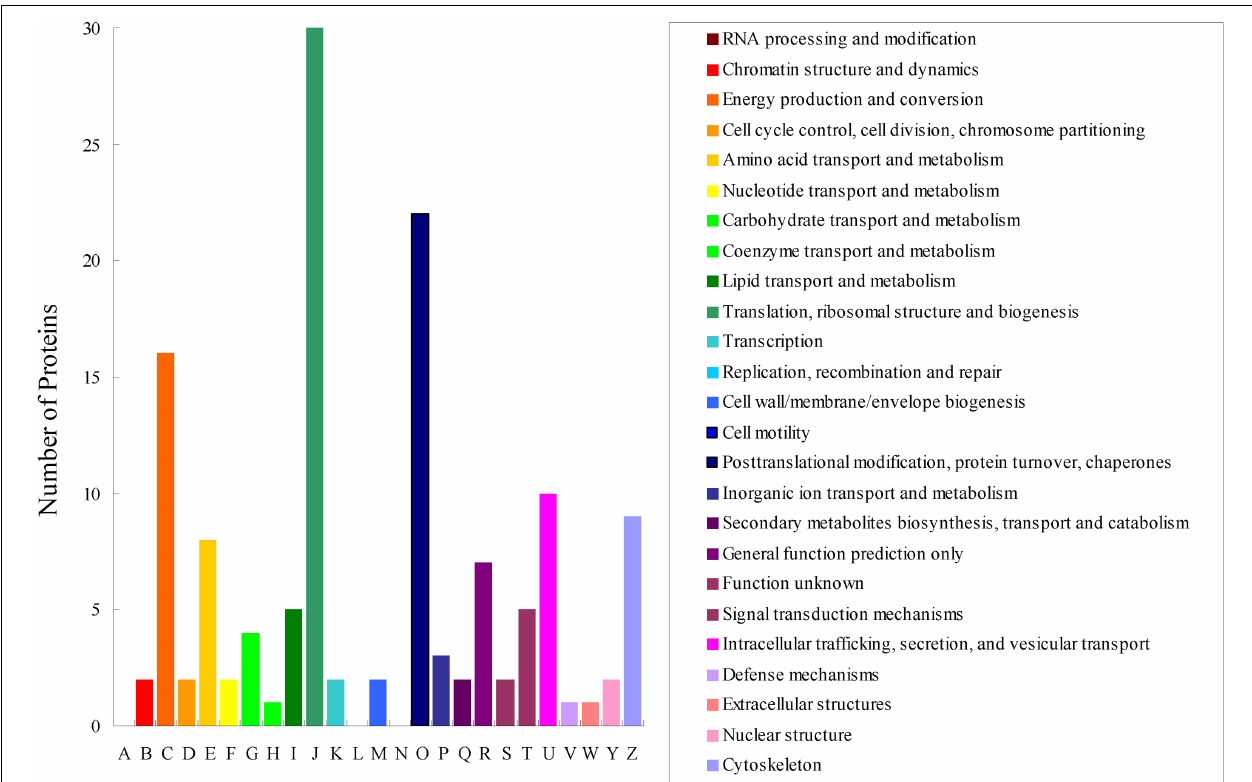
FIGURE 2 | COG functional classification of the differentially expressed proteins acquired via iTRAQ technology in the combinations CYR32-5 vs. CYR32, CYR32-61 vs. CYR32, and CYR32-61 vs.